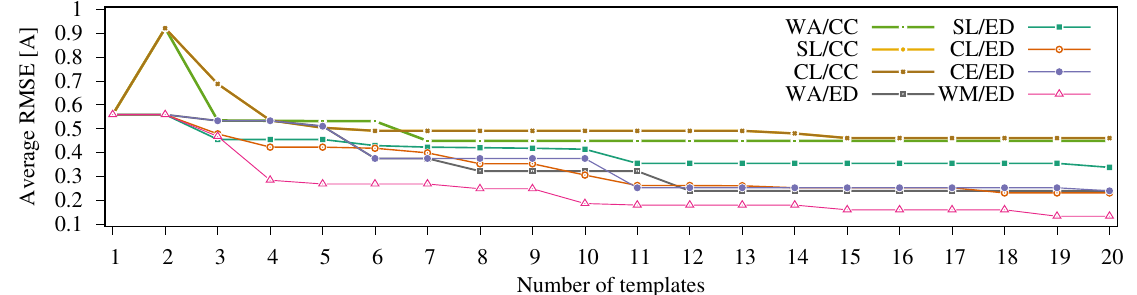
Figure 5. Observed RMSE values for eight distance/similarity metric combinations in relation to the number of templates extracted from the input